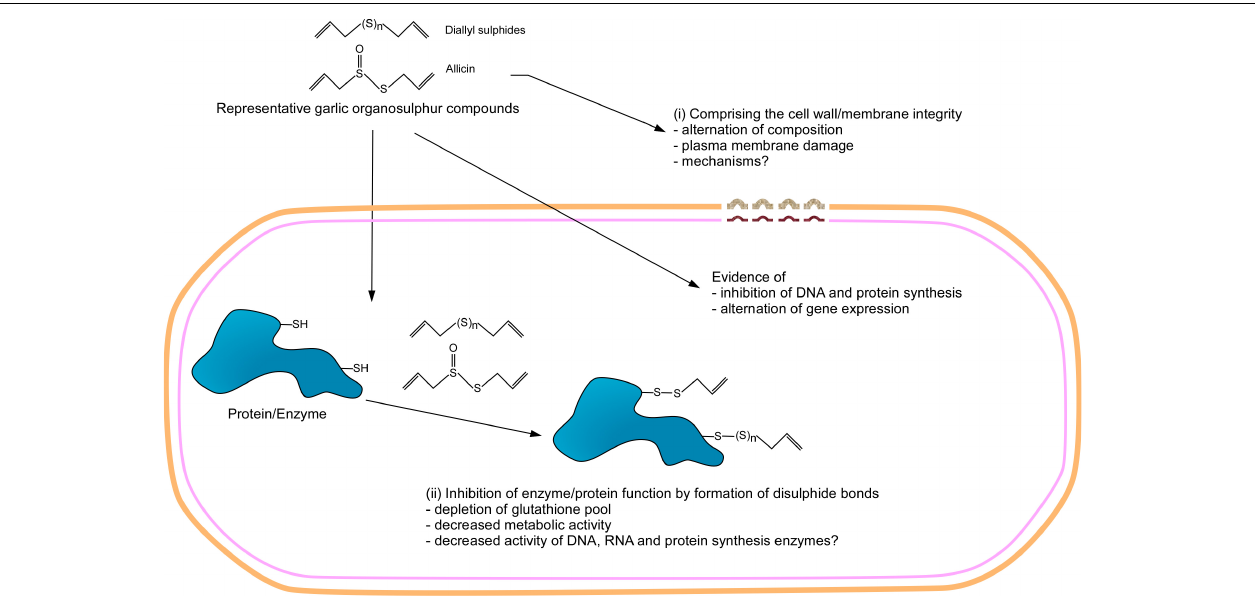
FIGURE 2 | Illustration of the mechanism of action of garlic organosulfur compounds. Garlic organosulfur compounds exert their antibacterial activity mainly through two mechanisms: (i) The organosulfur compounds are highly reactive with sulfur having the capability to form disulfide bonds with the free sulfhydryl groups of proteins including enzymes. The formation of disulfide bonds renders the enzyme inactive, resulting in the death of bacteria. (ii) The organosulfur compound interacts with the cell membrane of bacteria. This interaction compromises the integrity of the cell membranes of the bacteria leading to leakage of cell content leading to death. In addition, it is also thought that garlic organosulfur compounds interfere with protein production, DNA replication, and alter gene expression.